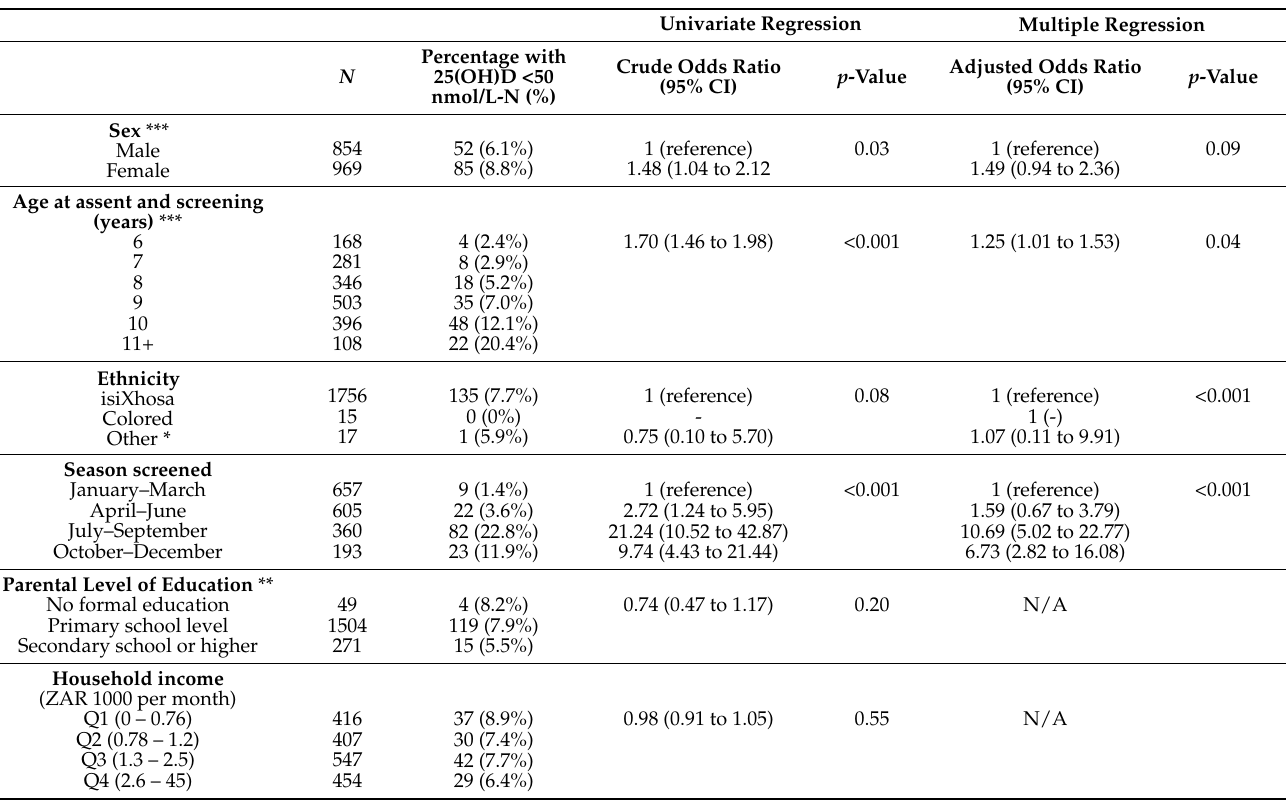
Table 2. Determinants of vitamin D deficiency (25[OH]D <50 nmol/L): univariate and multivariate logistic regression